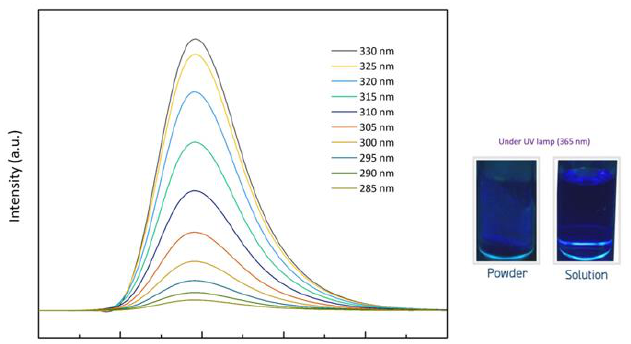
Figure 6. Emission spectra of copper coordinate complexes at each excitation wavelength.